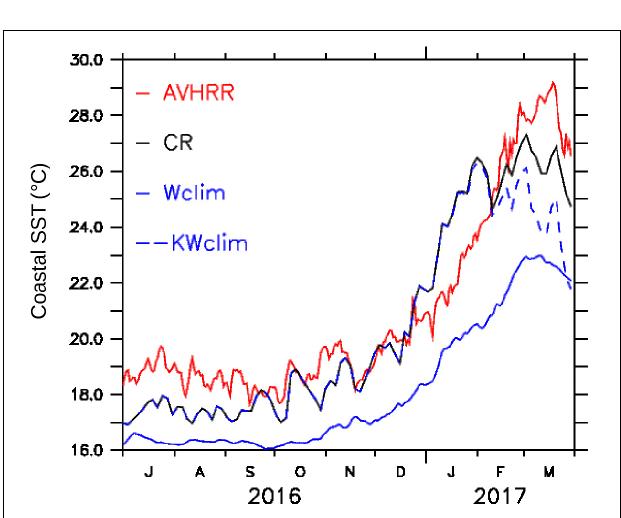
FIGURE 10 | Time evolution of the SST averaged in a coastal box (4–10 ◦ S, 0–100 km from the coast) for AVHRR observations (red line), CR (black line), Wclim (blue line), and KWclim (dashed blue line).